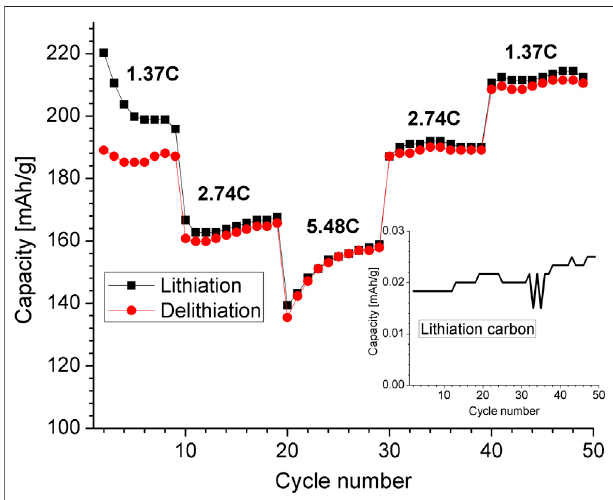
FIGURE 8 | Plot of capacity vs. cycle number of a half battery cell with Mx-Onyx-950C as working electrode, tested at different charge/ discharge